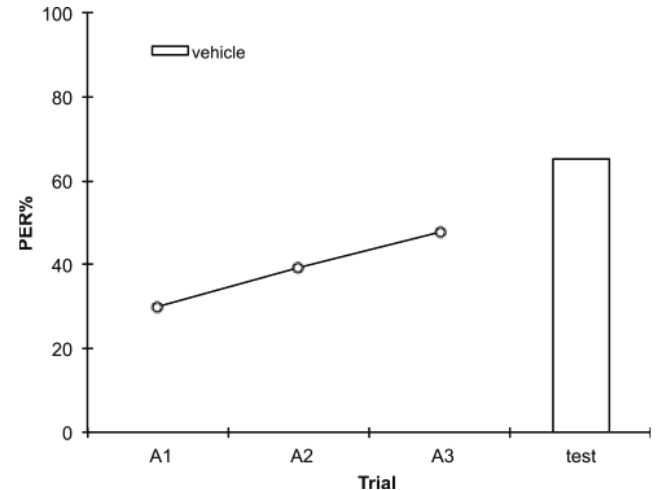
Figure 8. In this version of the proboscis extension reflex (PER) assay, discrimination learning increases linearly during training, and at the 24 h test approximately 2/3 of bees displayed the correct double response, indicating successful discrimination memory. Shown here are control bees from all experiments pooled ( n =